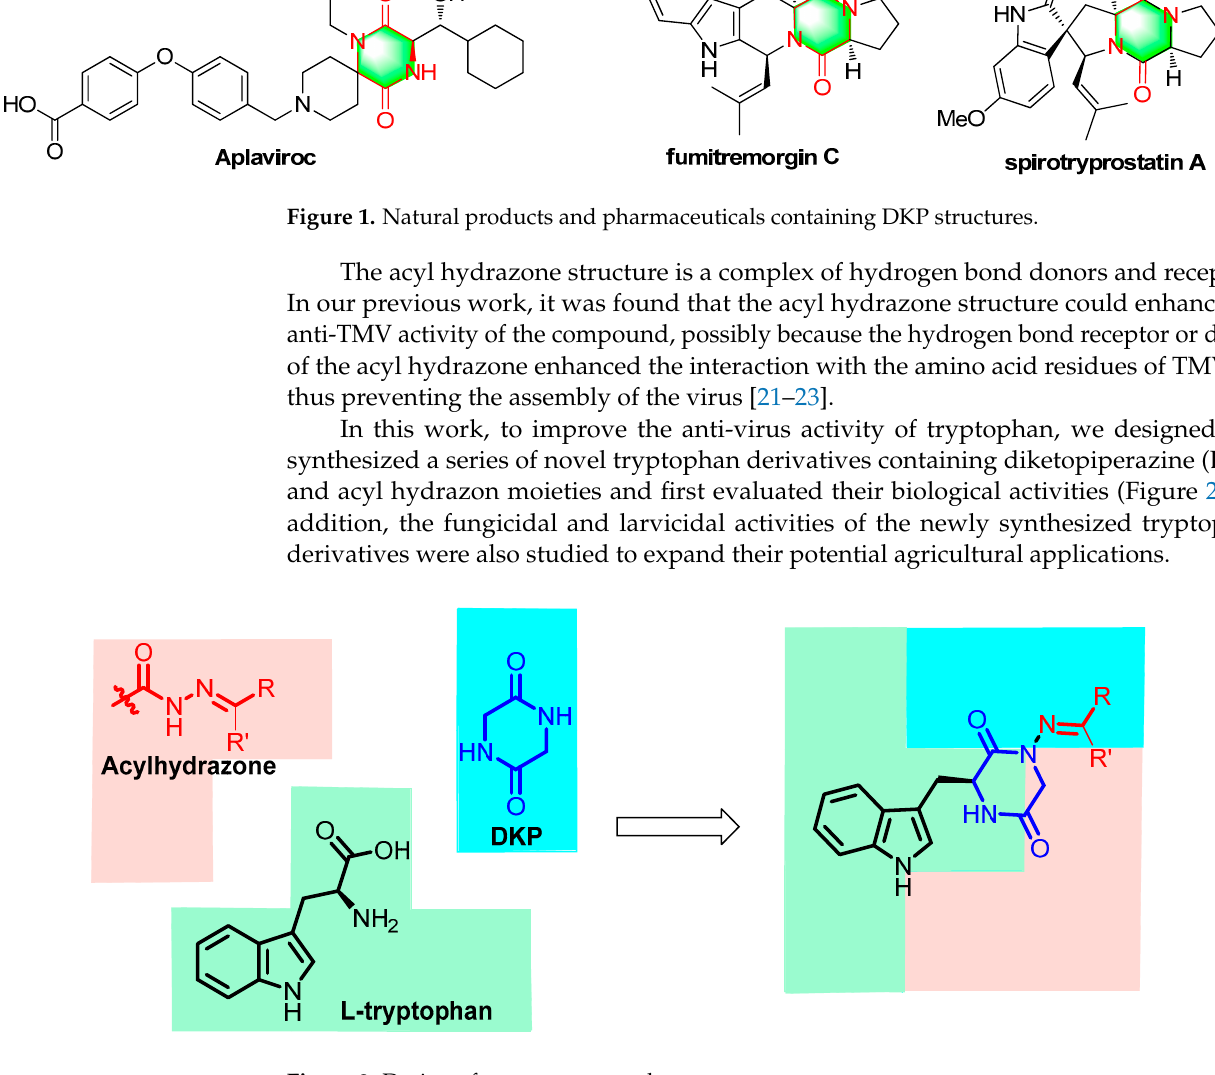
Figure 2. Design of target compounds.